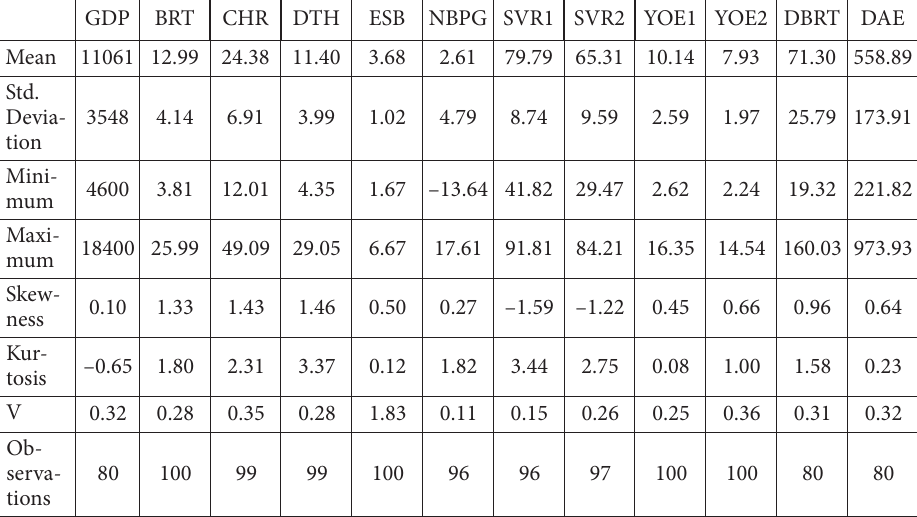
Table 2. The variables main characteristics (source: authors’ own computations based on Table 1) GDP